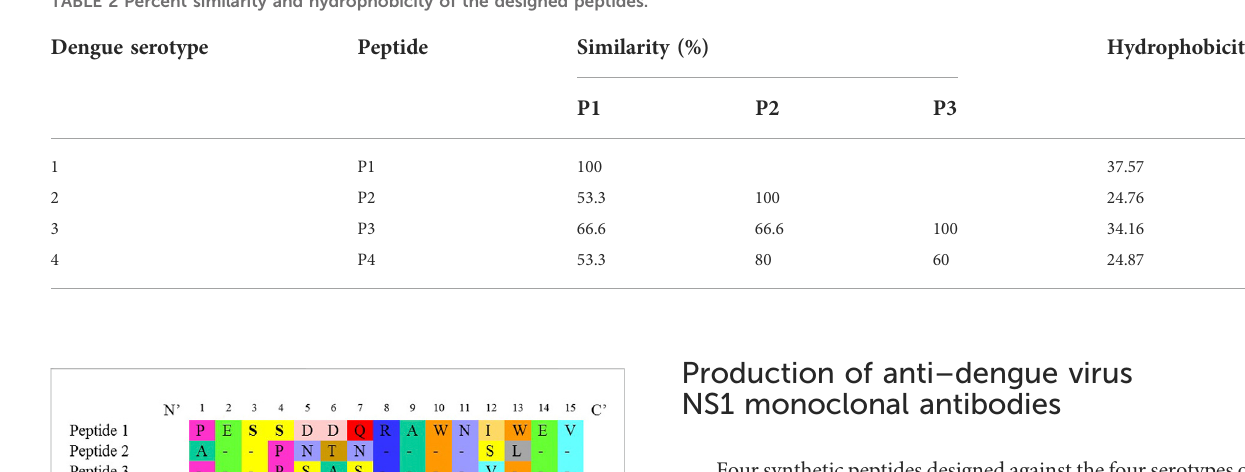
TABLE 2 Percent similarity and hydrophobicity of the designed peptides.